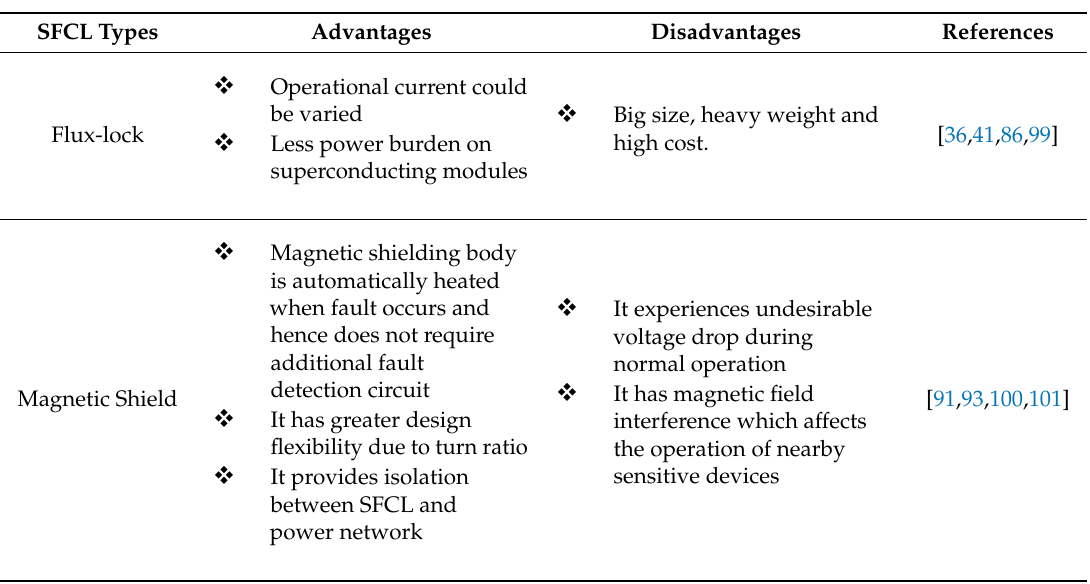
Figure 4. The phases for implementing a N-AHP in SWOT analysis.